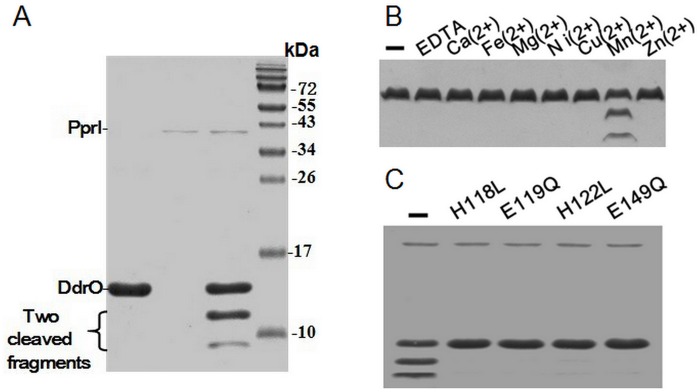
Metal dependence of PprI protease.(A) PprI cleavage activity in vitro was measured using purified PprI and DdrO protein. PprI cleaves DdrO into two fragments as indicated by the SDS-PAGE gel. (B) Metal ion scan for the protease activity. From left to right: without additive, 1 mM EDTA, 1 mM CaCl2, 1 mM FeCl2, 1 mM MgCl2, 1 mM NiSO4, 1 mM CuCl2, 1 mM MnCl2, 1 mM ZnCl2. Mn(2+) is necessary for the protease activity. (C) Mutations at the metal-binding sites of PprI abolish the proteolytic activity. From left to right: wild type PprI, H118L mutant, E119Q mutant, H122L mutant and E149Q mutant. These mutations were chosen based on the crystal structure from D. deserti (PDB code 3DTI) [9].